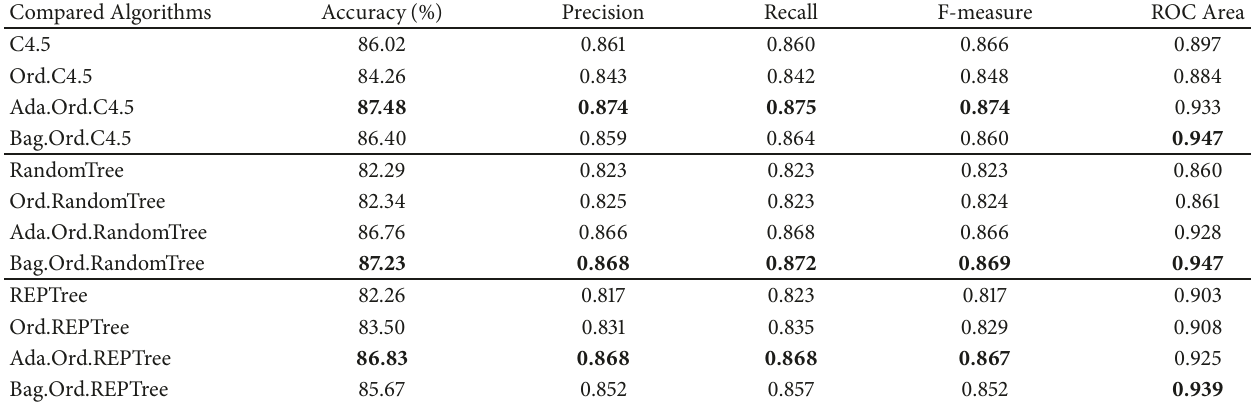
Table 9: The comparison of algorithms in terms of accuracy, precision, recall, F-measure, and ROC area. Compared Algorithms Accuracy (%) Precision